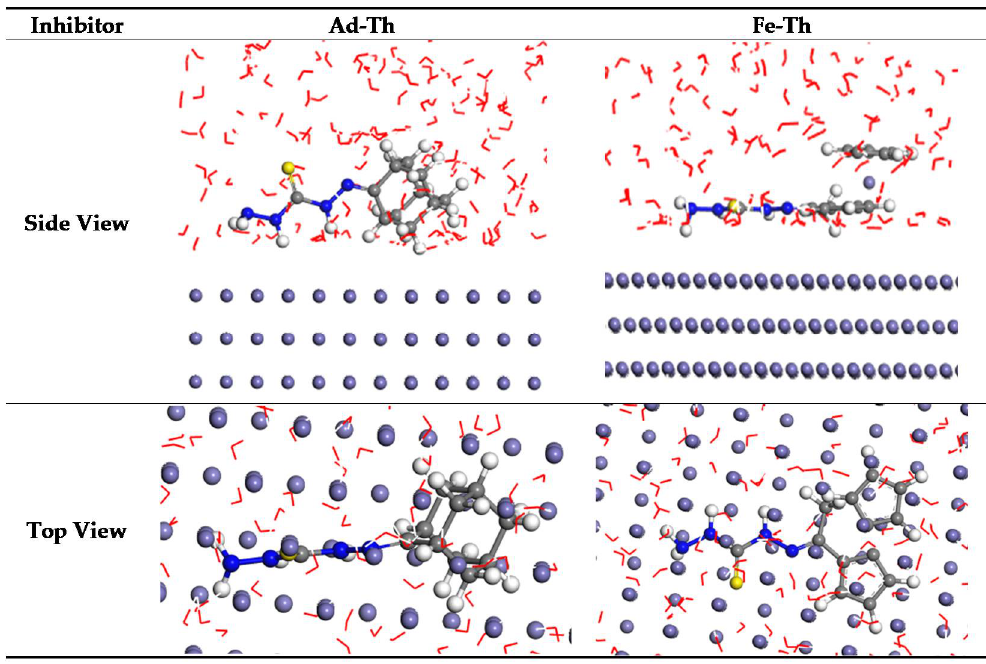
Figure 10. Top and side visions of the final adsorption of the Ad-Th and Ad-Fe on the iron (110) surface in solution. Table 4. Selected energy indices acquired from MC simulations for the adsorption of Ad-Th and Fe- Th molecules on Fe (110) surface.